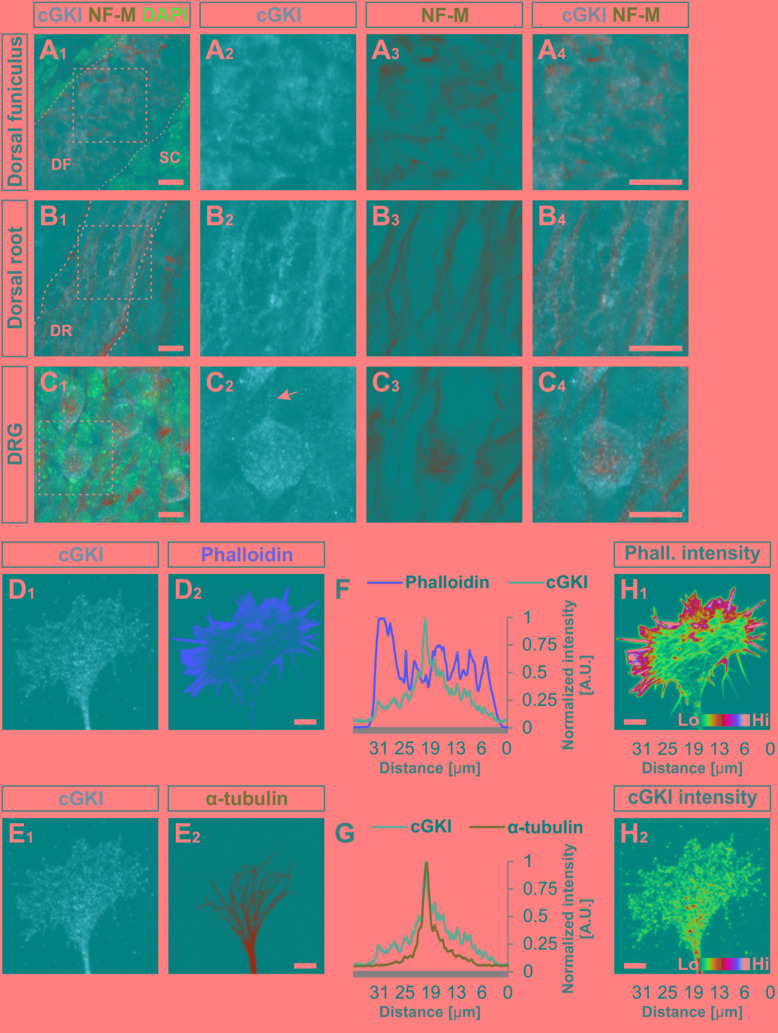
cGKI localizes in a vesicular-like pattern in sections of embryonic DRG neurons and in the central domain of cultivated DRG growth cones. (A1–A4) Transversal sections of the developing E12.5 mouse dorsal funiculus, (B1–B4) the dorsal root or (C1 – C4) DRG stained with anti-cGKI, anti-neurofilament-M or the nuclear stain DAPI. Higher magnifications of the squares indicated in (A1,B1,C4) are shown in (A4,B4,C4) respectively. Scale bar, 10 μm. (D–G) Localization of cGKI in growth cones of E12.5 DRG explants cultured on laminin1. (D1,D2) cGKI and F-actin (phalloidin). (E1,E2) cGKI and α-tubulin. Scale bar in (D2,E2) 5 μm. (F,G) Intensity profiles of a growth cone stained with anti-cGKI, F-actin (phalloidin) or α-tubulin summarized throughout the complete growth cone. Note that the intensity profile shown in (F,G) were taken from the entire growth cone. Along the Y-axis the intensity was summed up and shown along the X-axis (from the left to the right) using the profile tool in ZEN2011 software (Zeiss). (H1,H2) Pseudo-colored intensity pattern of phalloidin (H1) and cGKI (H2). Scale bar 5 μm. Phall., phalloidin; Lo, low; Hi, high. A.U., arbitrary unit.